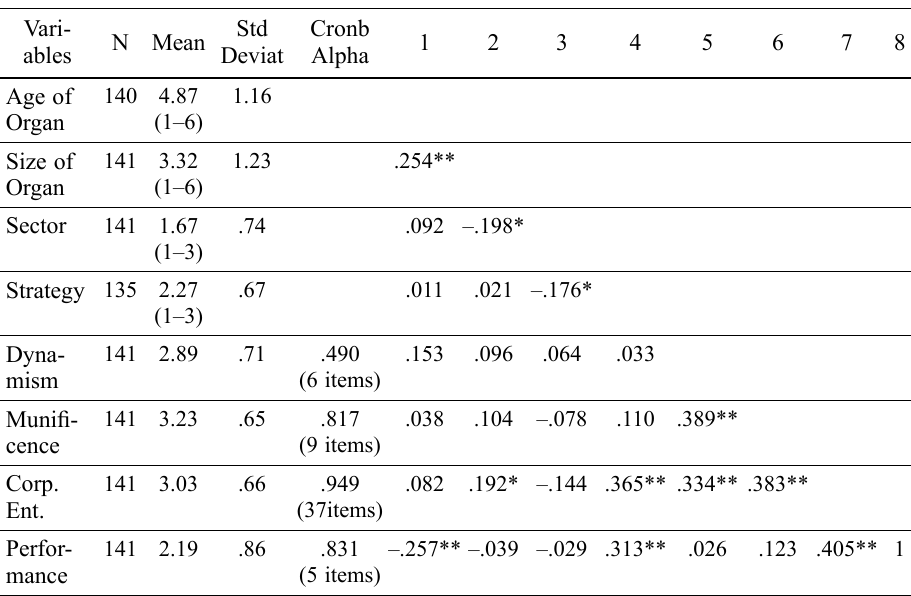
Table 3. Summary descriptive statistics, reliabilities and correlation matrix